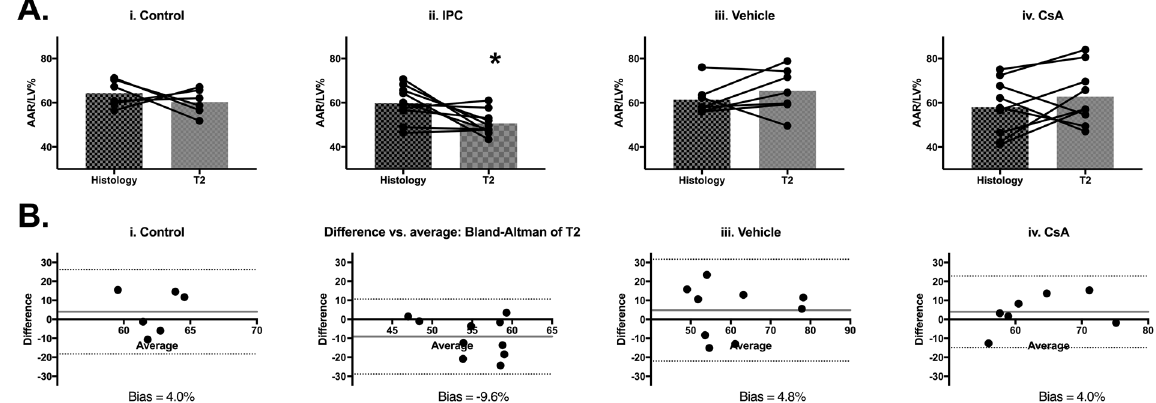
Figure 4. Validation of T 2 mapping to determine in vivo AAR in control and protected hearts upon IRI. ( A) Quantification of AAR as a fraction of left ventricle area (AAR/LV%) by histological staining and T 2 -mapping animals in control group (n = 6) (i), IPC group (n = 10) (ii), vehicle group (n = 8) (iii) and CsA group (n = 9) (iv). Mean ± standard deviation values are provided in Supp. Table 2. Significant underestimation of AAR/LV% is observed for the IPC group ( * p = 0.02). ( B ) Bland-Altman plots comparing histological and T 2 mapping methods of estimating AAR/LV% for all groups